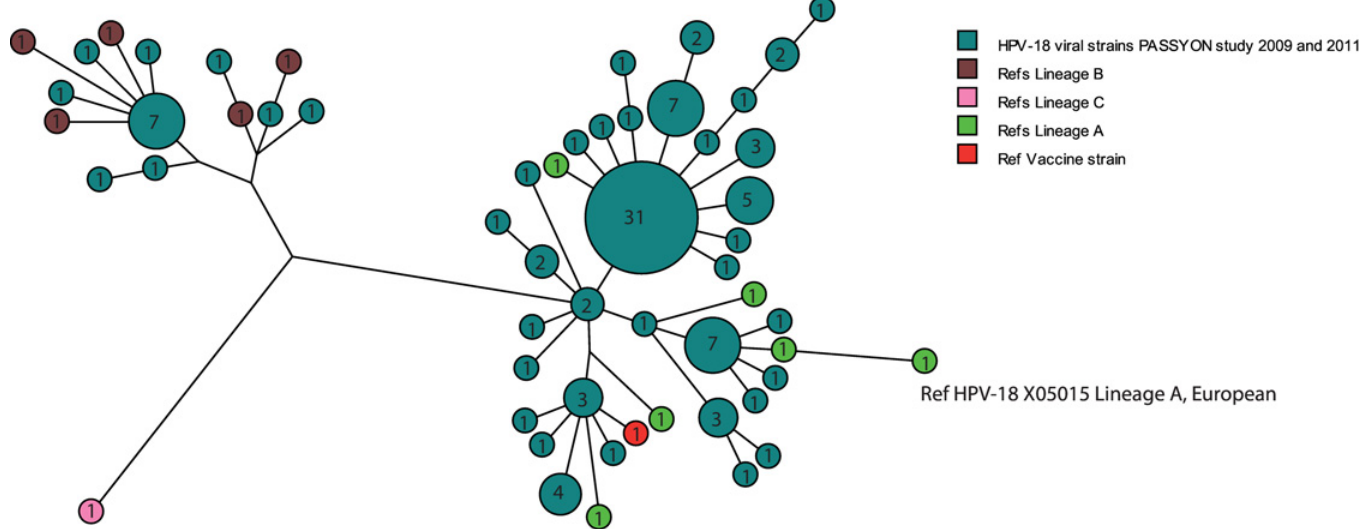
Fig 2. Maximum parsimony tree based on nucleotide sequences of L1 HPV-18 gene. Study sequences of 108 HPV-18 positive samples collected in 2009 and 2011 are shown in blue. Reference sequences of European/A lineages (GenBank reference X05015, AY262282 (sublineage A1), EF202146 (sublineage A2), EF202147 (sublineage A3), EF202151 (sublineage A4), CQ180787 (sublineage A5)), African/B lineages (GenBank references EF202153, EF202154, EF202155 (sublineage B1)) KC470225 (sublineage B2) EF202152 (sublineage B3), and reference for lineage C (KC47229) are shown in green, brown and pink respectively. HPV-18 variant used in the vaccine (GenBank reference AY863161) is shown in red. The number given in each circle indicates the number of viral strains with the same sequence.